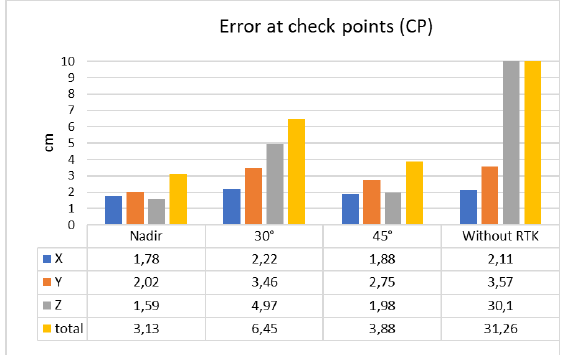
Figure 12. Deviations of check points (CP) without ground control points (GCP)